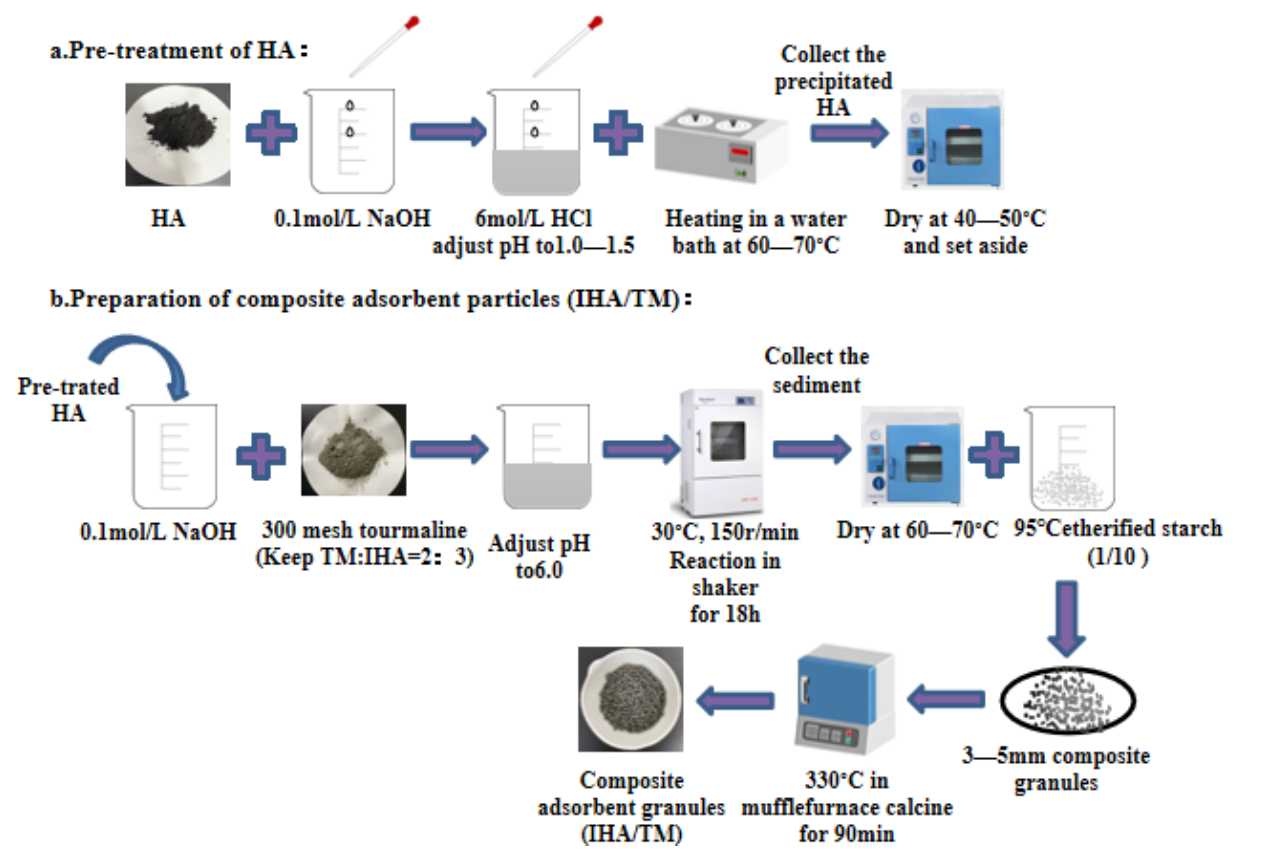
Figure 1. Preparation process of IHA/TM.